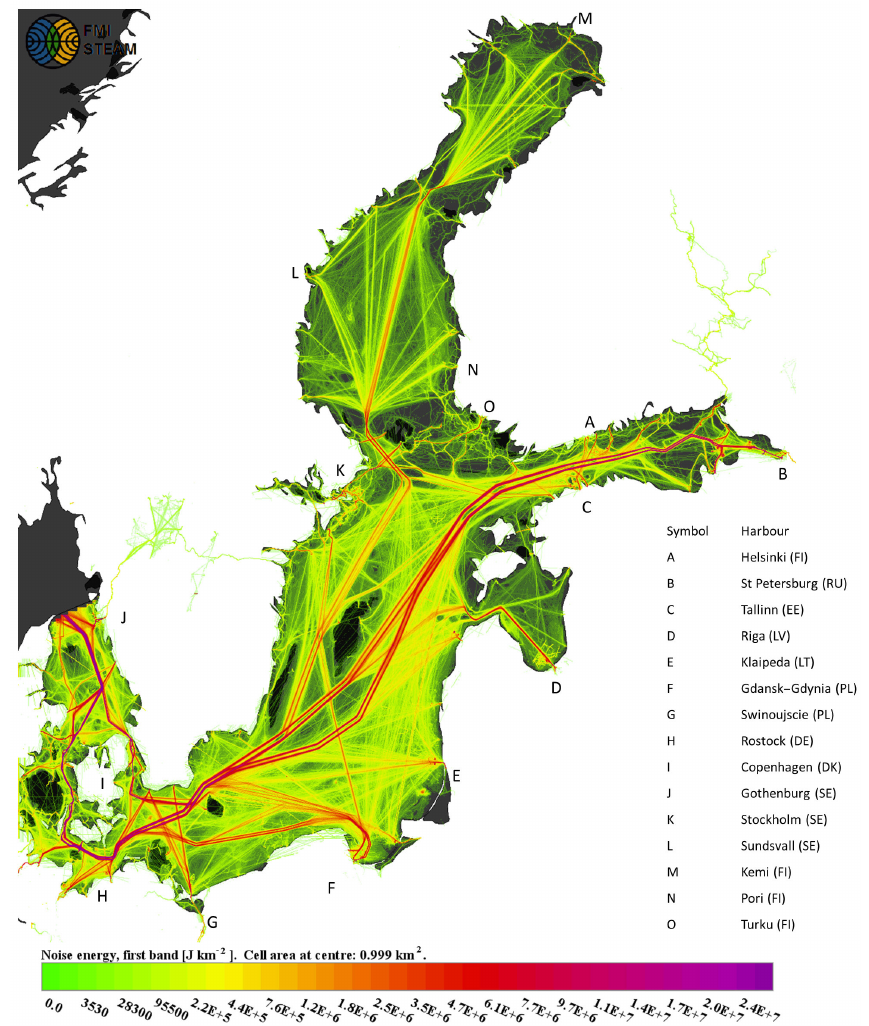
Figure 3. Noise source map for Baltic Sea shipping. This map indicates the sum of sound energy in units of joules per grid cell (cell area 1km 2 ) during the year